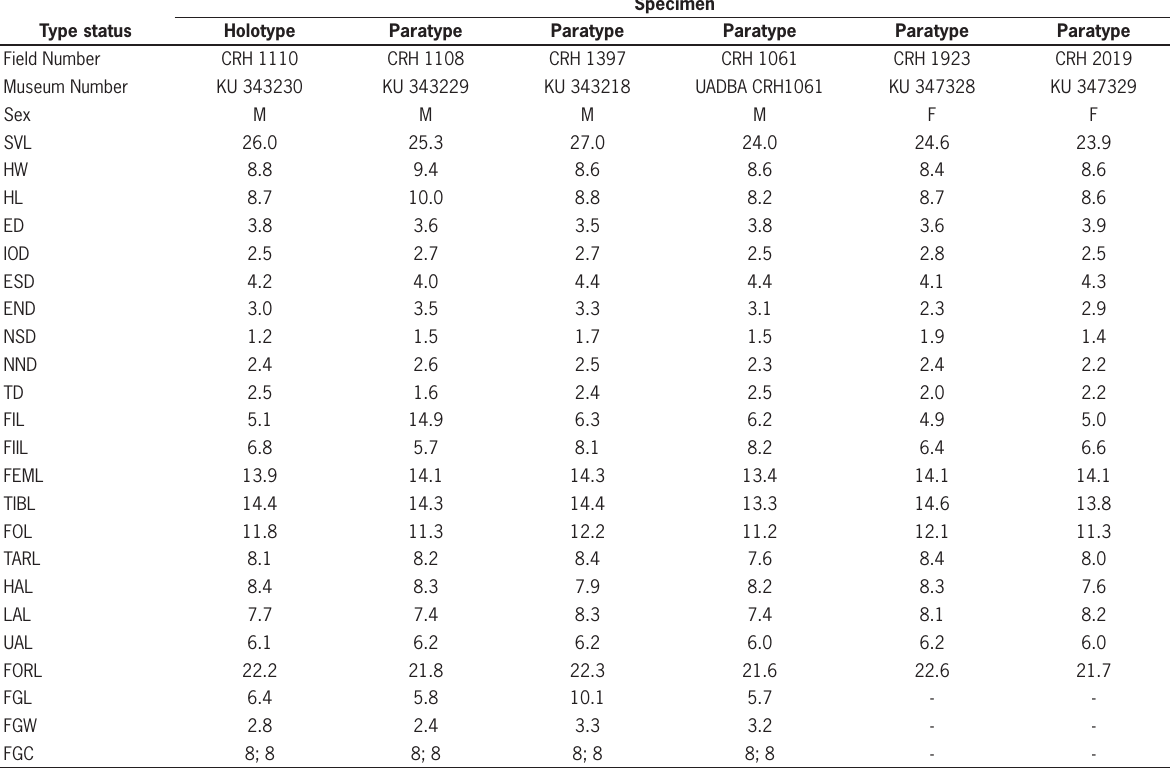
Table 2. Morphometric measurements (in mm) of the holotype and paratypes of Gephyromantis marokoroko sp. nov. Femoral Gland Clusters (FGC) shown as “left, right”